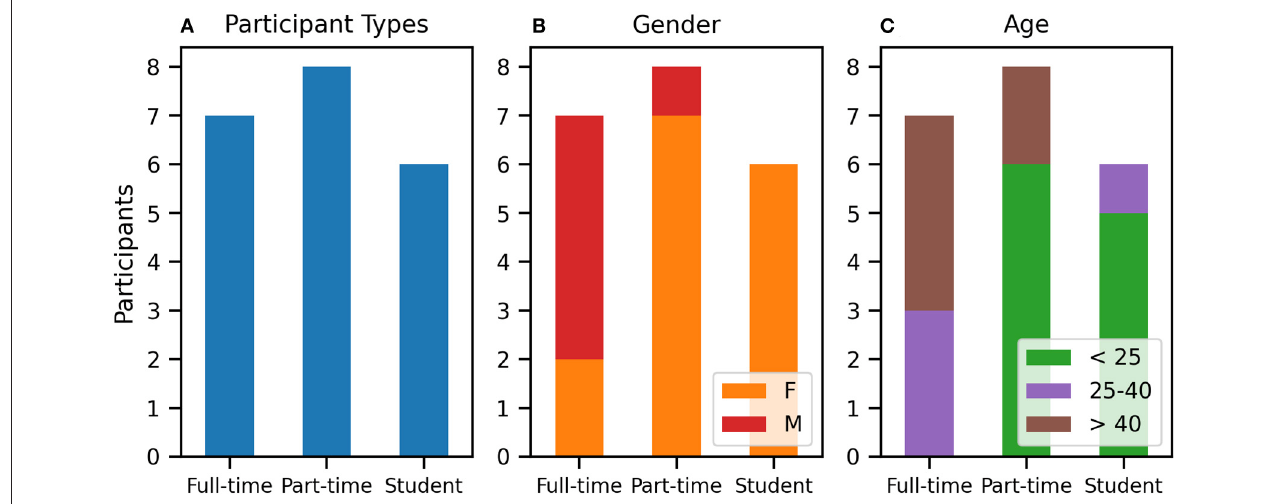
FIGURE 1 | Study participants, showing (A) drawing practitioner types, (B) gender, and (C) age distributions.